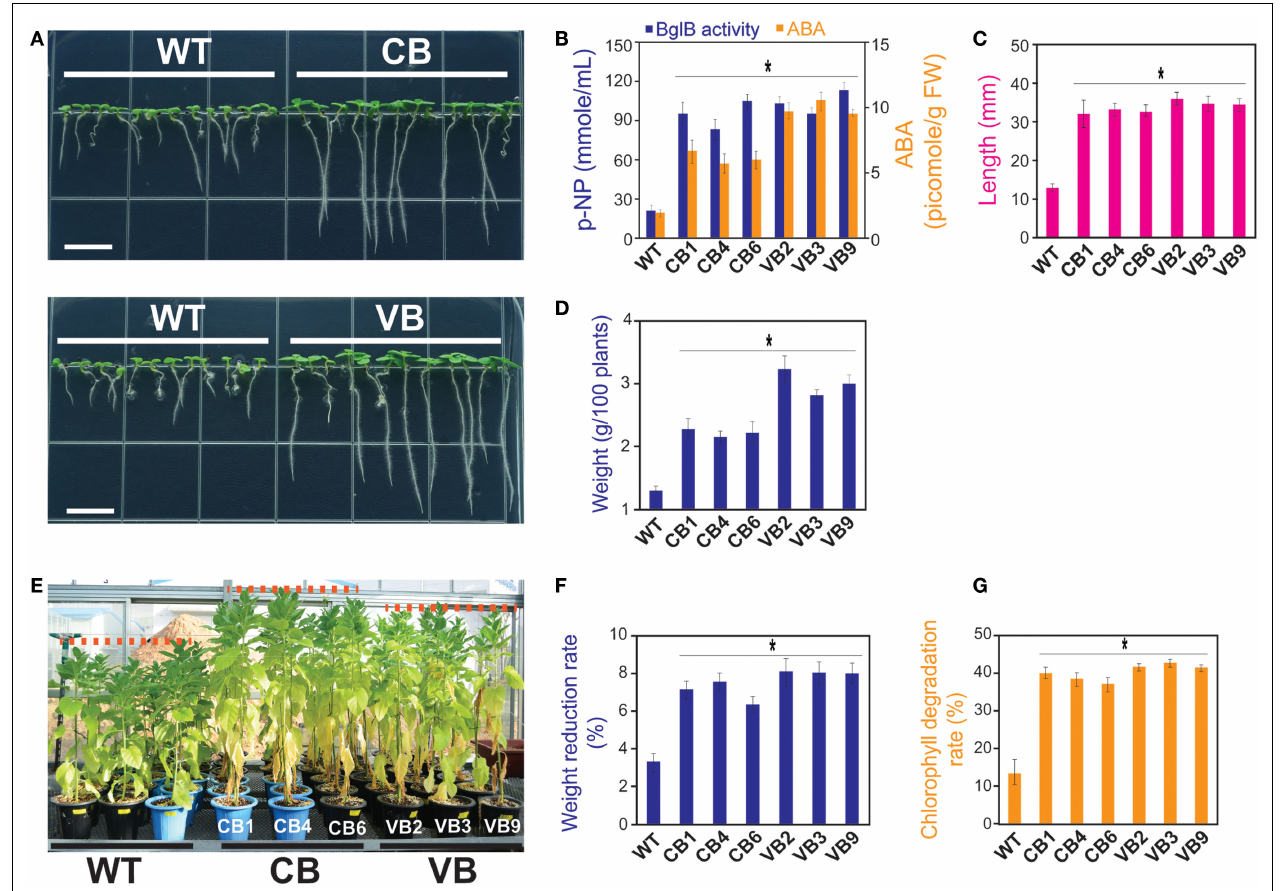
FIGURE 5 | Heterologously expressed BglB transgenic plants showed higher tolerance to salt stress in young seedlings, but triggered programed cell deaths occurred sooner in mature plants compared to WT plants . After 15 DAG in MS media containing 200mM NaCl: (A) Faster development of the stems and roots of the CB and VB transgenic seedlings; (B) Combination of β -glucosidase enzymatic activity and ABA levels of the transgenic and WT seedlings; (C) Root lengths; and (D) Fresh weight of 100 seedlings of the transgenic and WT seedlings. Average values were calculated from triplicated. After 10days treated with 200mM NaCl in the greenhouse: (E) More senescent leaves appeared in the transgenic plants compared to WT plants; (F) Weight reduction rate; and (G) Chlorophyll degradation rate of the transgenic and WT plants. Average values were calculated from triplicate ( n = 3) of each transgenic lines and WT plants for (B) , twenty seedlings ( n = 20) of each transgenic lines and WT plants for (C) , triplicate ( n = 3) of each transgenic lines and WT plants for (D) , ten individuals ( n = 10) of each transgenic lines and WT plants for (F,G) . *indicates significant differences from the control (WT) ( P <